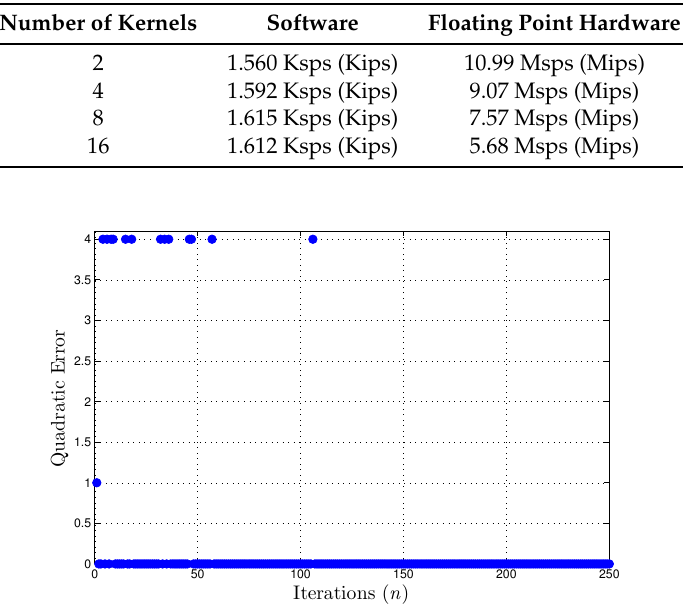
Table 9. Throughput, th , of the Iris dataset—floating point.